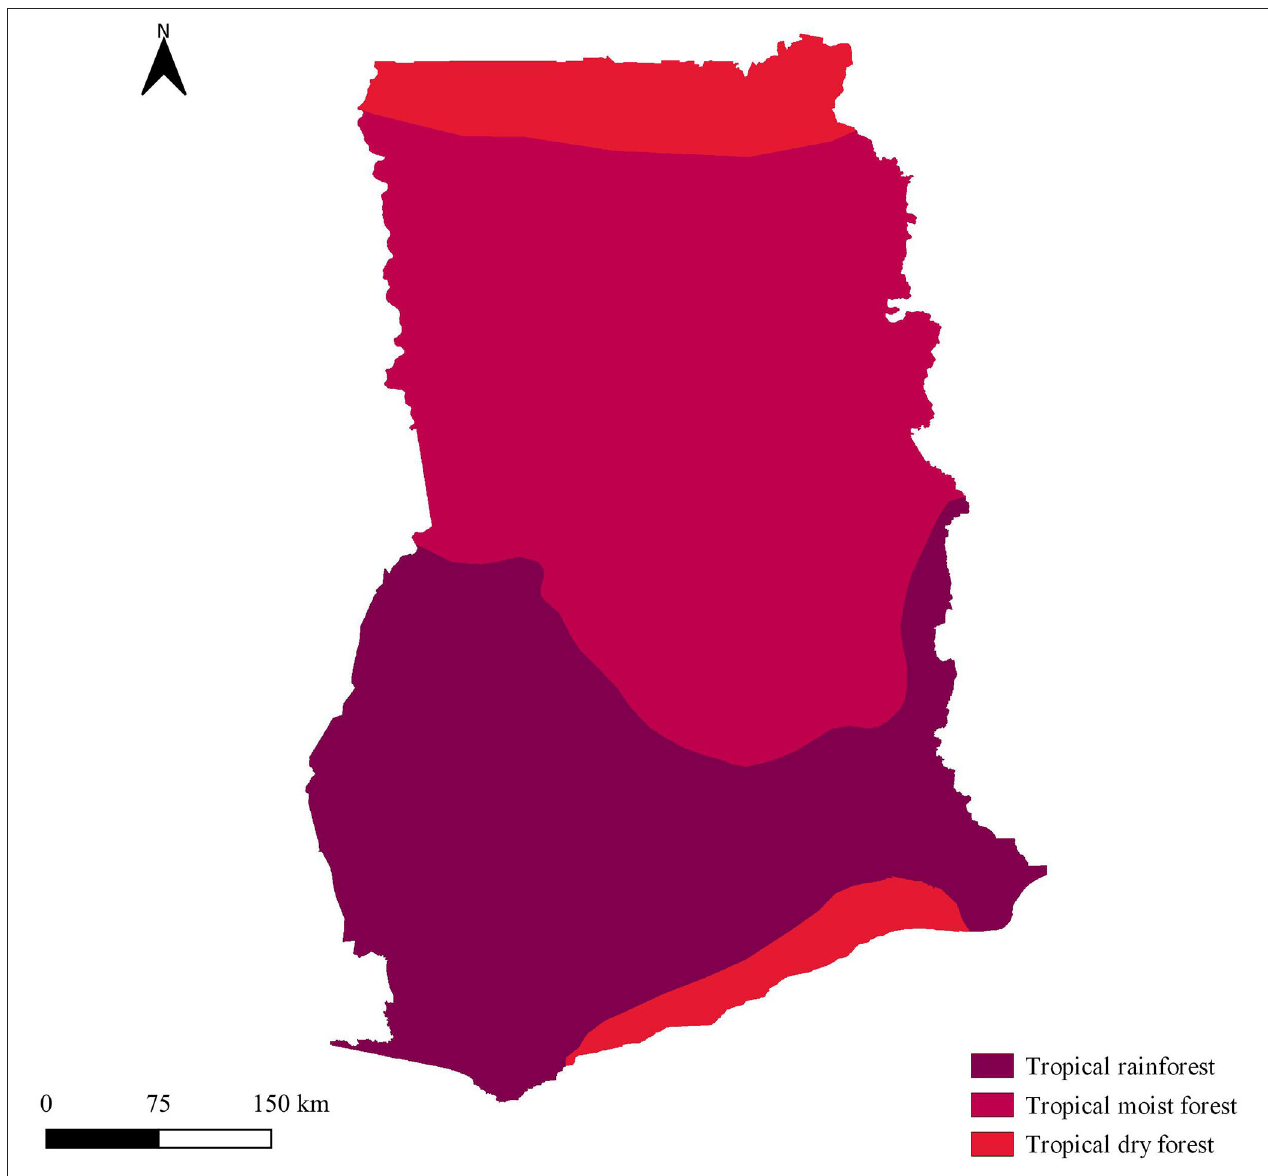
FIGURE 4 | Ecological zones in